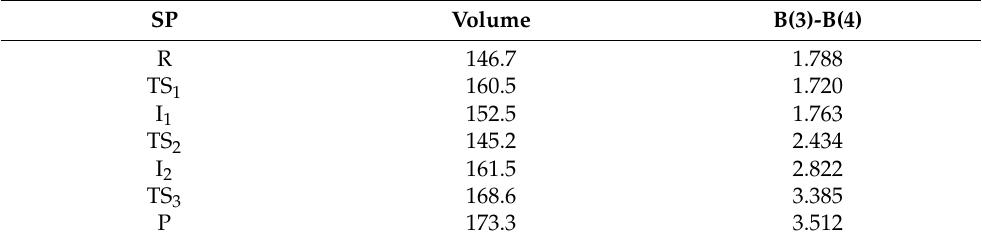
Table 2. Electronic volumes (Å 3 ) and B(3)-B(4) distance (Å) of the stationary points (SP) along the IRC for the 3D → 2D isomerization of B 6 H 12 —Figure